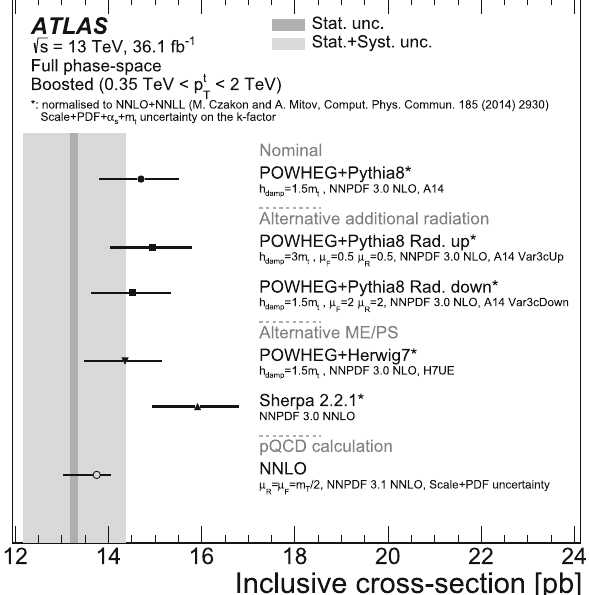
Fig. 68 Comparison of the measured inclusive parton-level cross- section in the boosted topology with the predictions from several MC generators and the NNLO prediction obtained using the NNPDF3.1 NNLO PDF set. The uncertainties associated to the NNLO prediction havebeencalculatedstartingfromthescaleandPDFuncertaintiesasso- ciatedtotheNNLOpredictionofthedifferentialcross-sectionasafunc- tion of p t . The uncertainty on the cross-section predicted by each NLO T MC generator only includes the uncertainty (due to PDFs, m t and α s ) affecting the k -factor used in the normalisation. The bands represent the statistical and total uncertainty in the